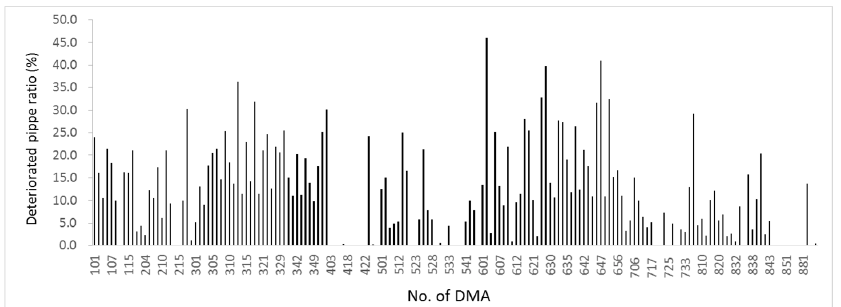
Figure 7. Data on Deteriorated Pipe Ratio in Incheon’s DMAs.